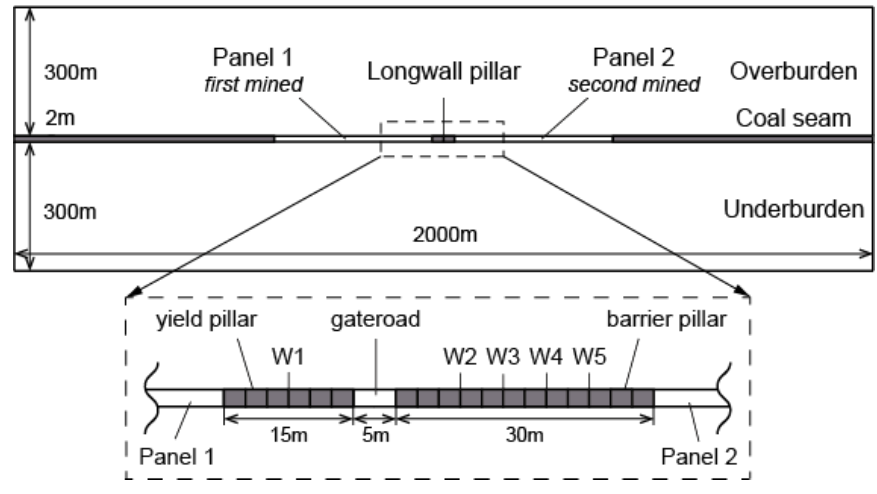
Figure 2. Schematic diagram of the base model (Pillar geometry between the twin extracted panels is shown in the excerpted frame. Panel 1 is removed first and then panel 2 is removed afterwards.).